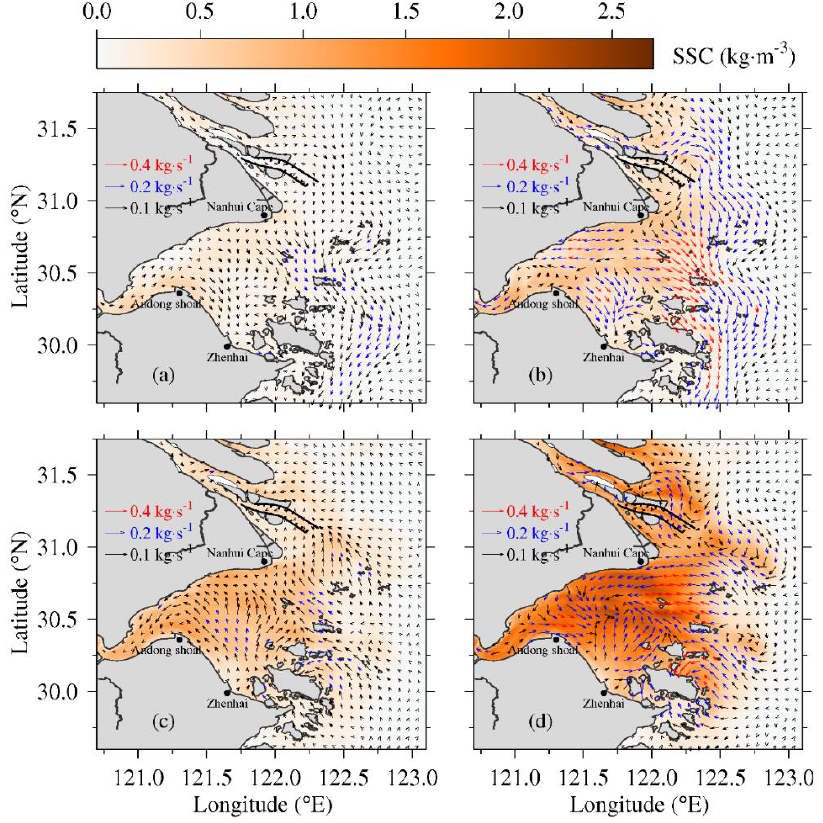
Figure 12. Distribution of the RUSF and SSC in the surface layer (upper panel) and bottom layer (lower panel) during neap tide ( a , c ) and spring tide ( b , d ) in winter.